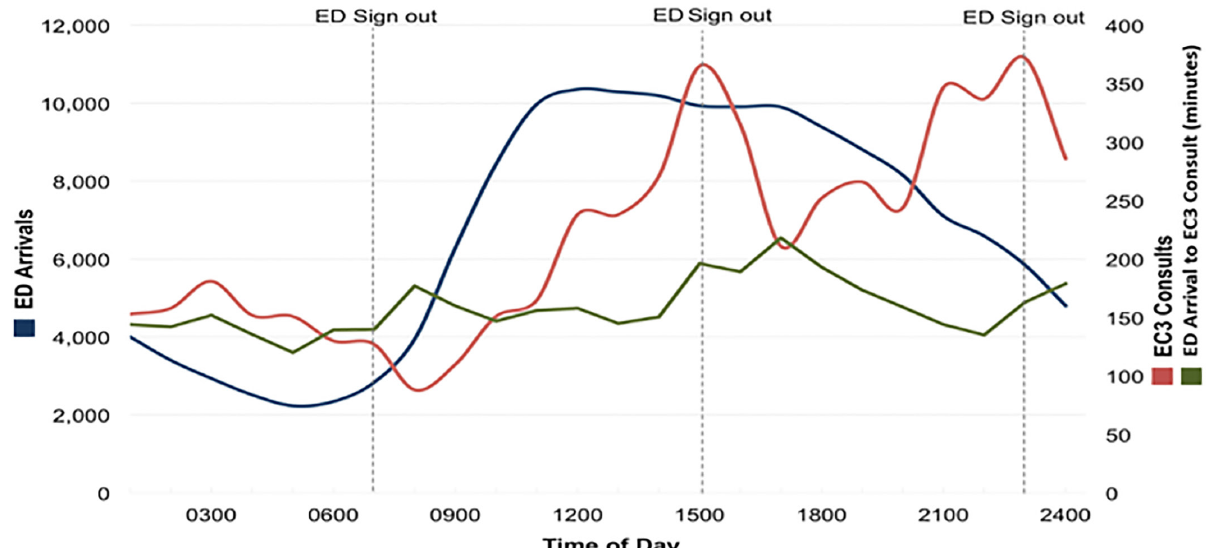
Figure 1. Comparison between ED arrivals (blue), ED-ICU (EC3) consults (red), and time from ED arrival to ED-ICU consult (green). ED, emergency department; ED-ICU, emergency department-based intensive care unit; EC3, emergency critical care